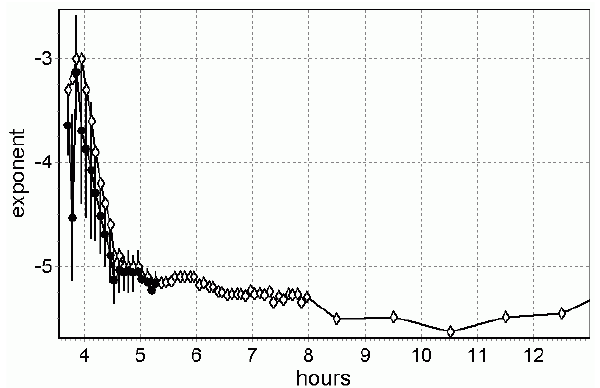
Fig. 9. Differential fluxes of solar protons with energies 0.5, 1, 2, 4, 8 and